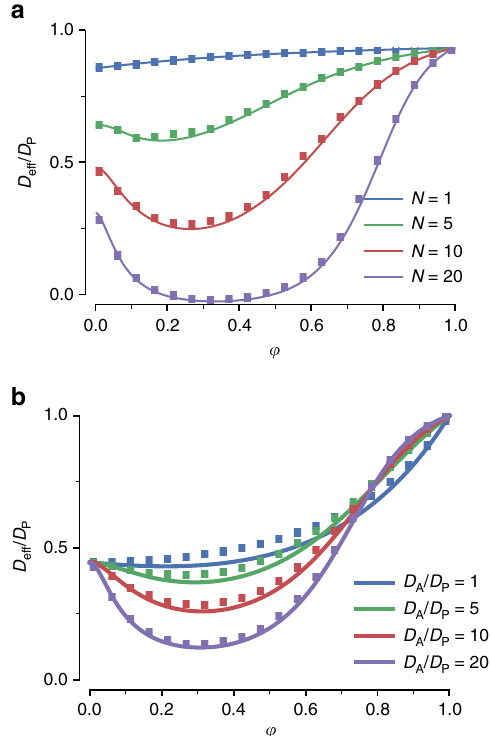
Fig. 3 Effective diffusivity of nanoparticulates vs. free fraction of anchors. Monte-Carlo simulations varied values of a N , the maximum number of binding sites on the nanoparticle, and b D A / D P , the ratio of the anchor diffusivity to the nanoparticle diffusivity. Parameter values used were τ = τ N = 15, and D D = A / P AP AM ¼ 20,